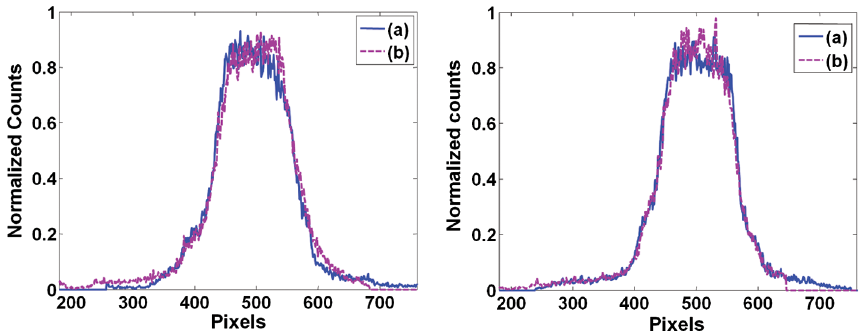
FIG. 13. Left: Horizontal and right: vertical line scans of the two cases shown in Fig. 12.